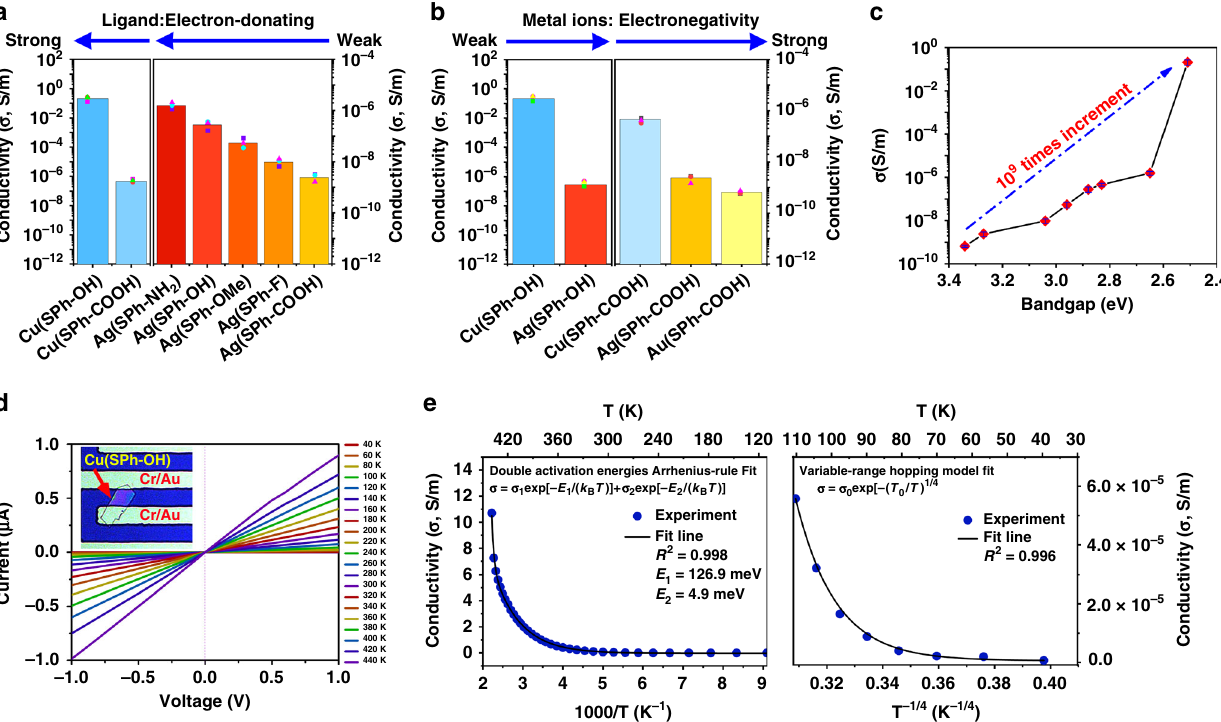
Fig. 4 Conductivity studies of OMCs. a, b Electronic conductivity of OMCs arranged according to the electron-donating ability of organic ligands and electronegativity of metal ions, respectively; c Band gap dependent conductivity of OMCs (Error bar, mean±s.d.); d Optical photograph of 25 nm thick Cu (SPh-OH) inbetween Cr/Au electrodes and its temperature-dependent I – V curves; e Variable temperature conductive measurements of Cu(SPh-OH) in d ; σ -T − 1 plot between 110 and 440 K (left); the solid line is the fi tting curve based on double activation energies equation; σ -T − 1/4 between 40 and 100 K (right); the solid line is the fi tting curve based on Mott variable-range hopping